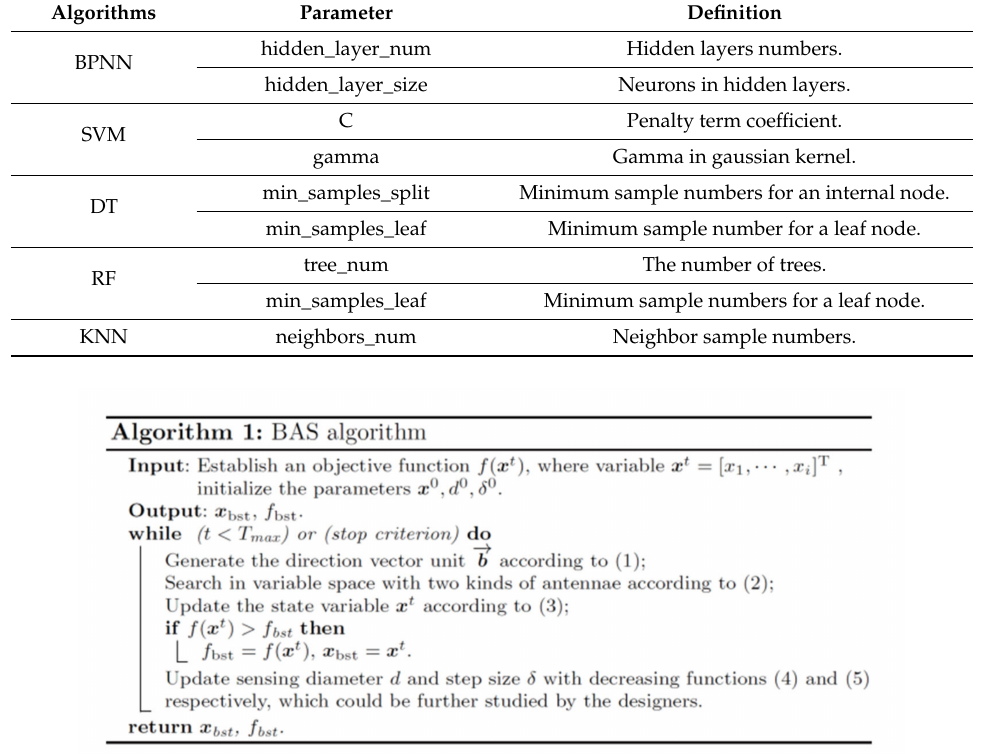
Figure 1. The pseudo code of